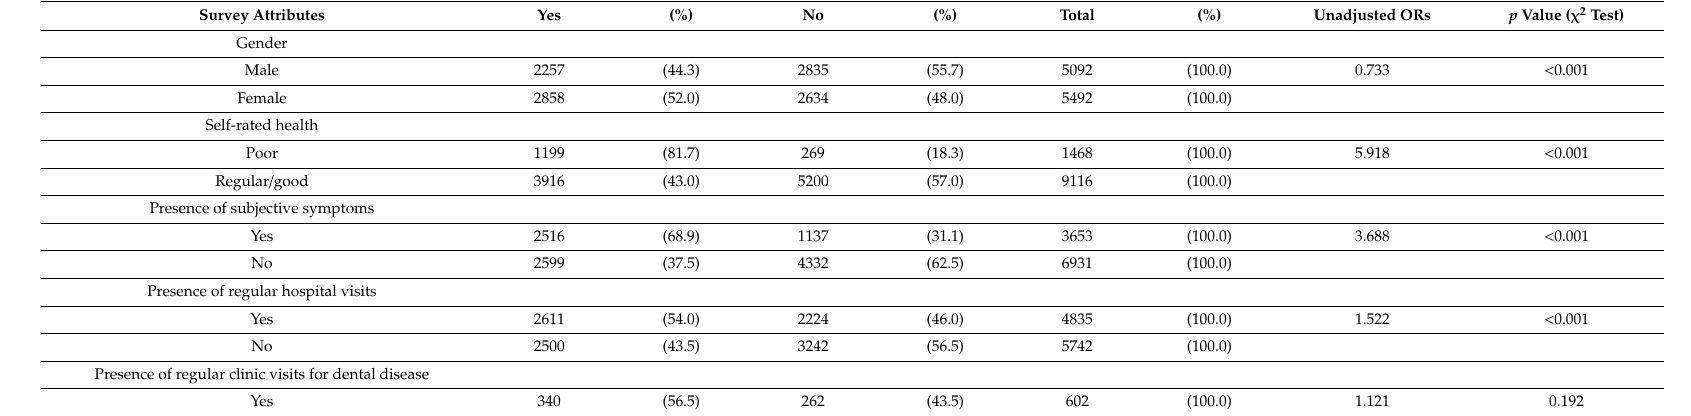
Table 5. Comparison of responses to survey items by presence of worries / stress, and unadjusted odds